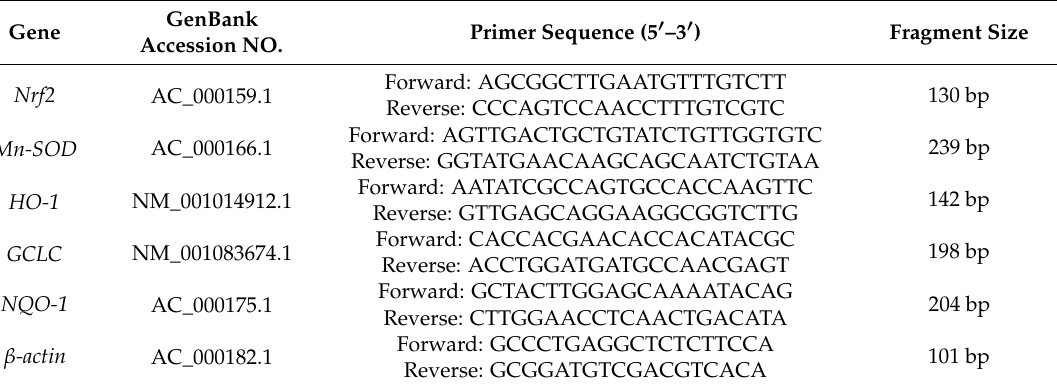
Table 1. Parameters for chemical